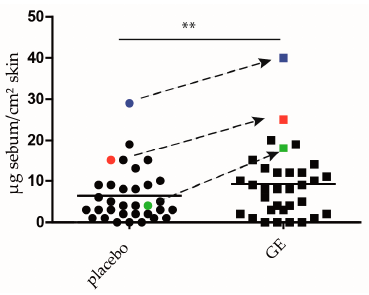
Figure 6. GE increases lipid synthesis in vivo. In a placebo controlled half side comparison, 33 adult volunteers were treated on their volar forearms with 5% GE cream, or placebo cream. The box blots show the lipid content of the skin after 2 weeks. The red, green and blue dots and squares correspond to one volunteer respectively. The arrows show the difference in the lipid content between the placebo and GE-treated forearm. The p value is indicated in the figures by asterisks (** p < 0.01).